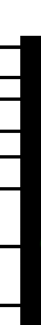
Figure 7. Dimer formation of ScSuFP in solution revealed by pseudo-native gel-electrophoresis. eGFP and Kaede were used as a control of monomer and obligatory tetramer, respectively. The photograph was taken through ALSC-56 filter under blue light illumination at 480 nm. Molecular weight standards are shown on the left of the gel. Lanes: 1—eGFP (monomer); 2—ScSuFP; 3—Kaede (tetramer).